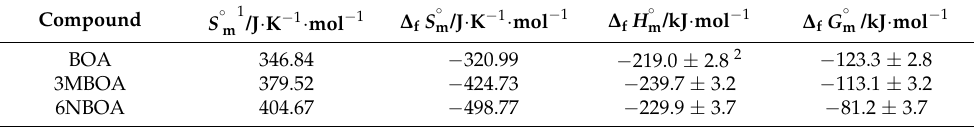
Table 5. Standard ( p ◦ = 0.1 MPa) molar absolute entropies and standard molar entropies, enthalpies and Gibbs energies of formation of benzoxazolinones studied in the gaseous phase, at T = 298.15 K.